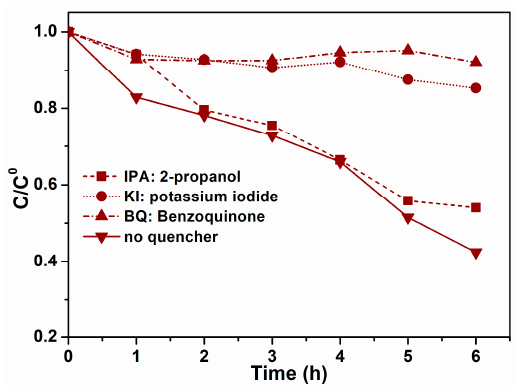
Figure 7. Photocatalytic degradation of MO under visible light ( λ > 420 nm) over YFeO 3 hex ‐ 675 after addition of several trapping reagents in order to identify the active species.